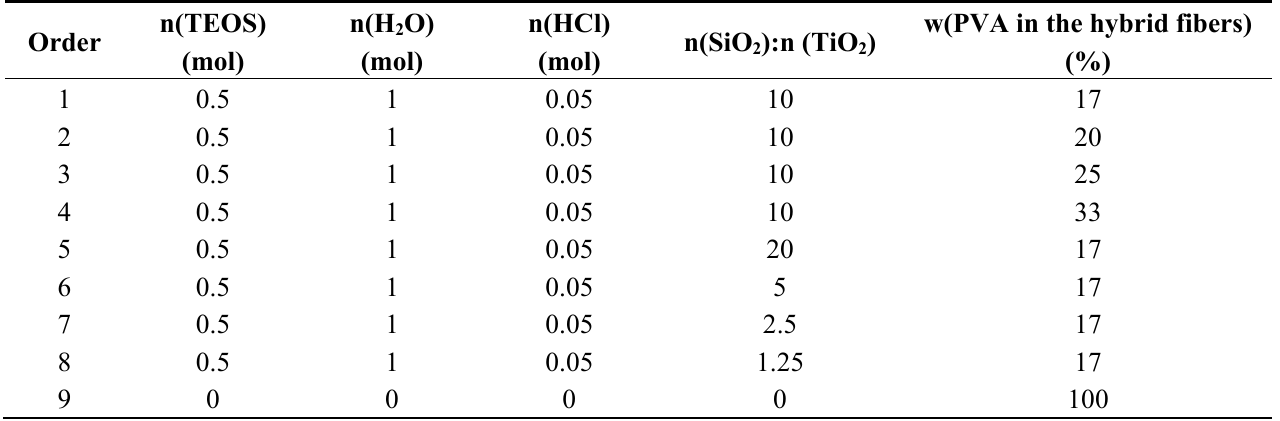
Table 1. Recipe for the hybrid sols